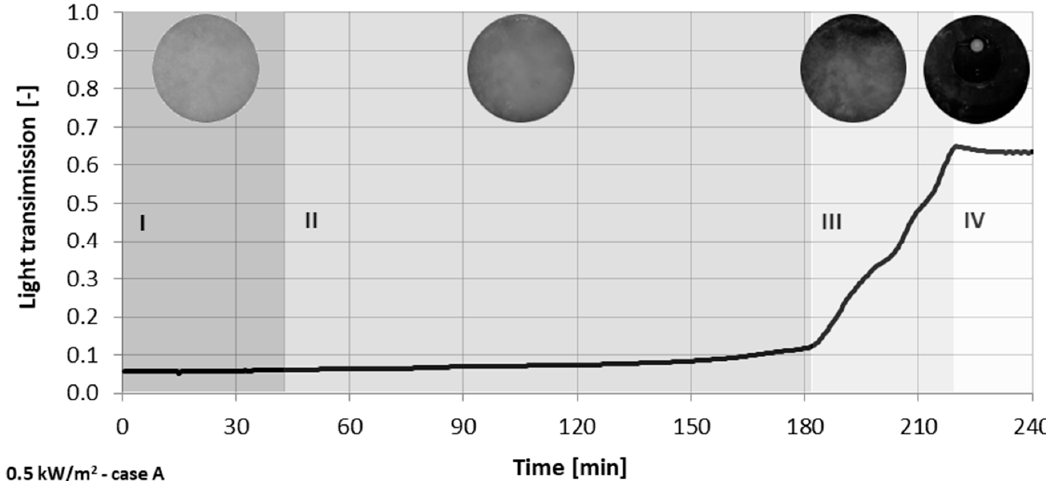
Figure 9. Direct light transmission versus time for an irradiance of 500 W/m 2 , case A.